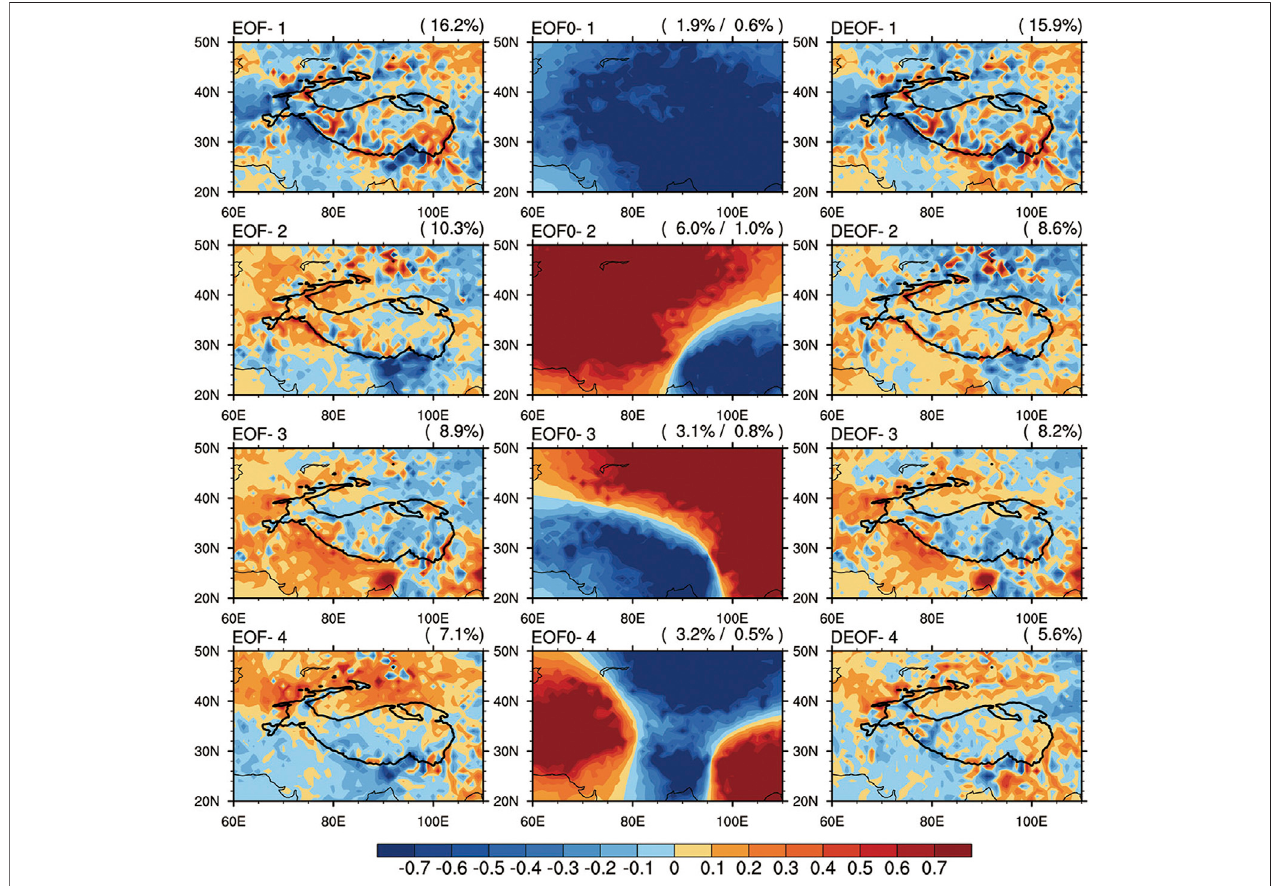
FIGURE 3 | Spring 〈 Q 1 〉 in the QTP and surrounding area during the time period 1979 – 2020 showing the EOF1-4 modes ( fi rst column), the stochastic null hypothesis one to four modes (second column) and the DEOF1-4 modes (third column) based on the interpolated ERA5 data of 1 ° resolution (the DEOF result of 0.25 ° resolutionisshownin SupplementaryFigureS2 ).Theblacklinesarethe3,000 maltitudelines.ThenumbersintheupperrightcorneroftheEOF/DEOFmodesarethe corresponding variance contributions, and the numbers in the upper right corner of the null hypothetical process are the corresponding variance contributions of EOF/DEOF modes to the null hypothetical